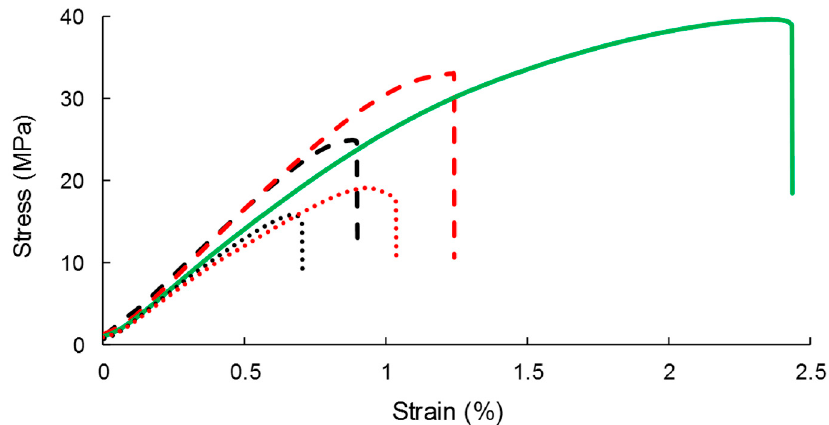
Figure 8. Representative stress–strain curves of the composites materials: PHBV ( - ), PHBV-10VC ( - - ), PHBV-10GC ( - - ), PHBV-33VC ( ··· ), PHBV-33GC ( ··· ).